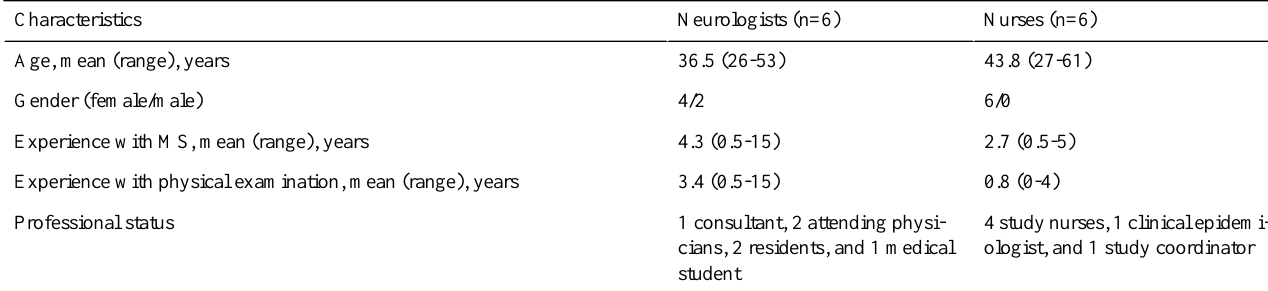
Nurses (n=6)Neurologists (n=6)Characteristics